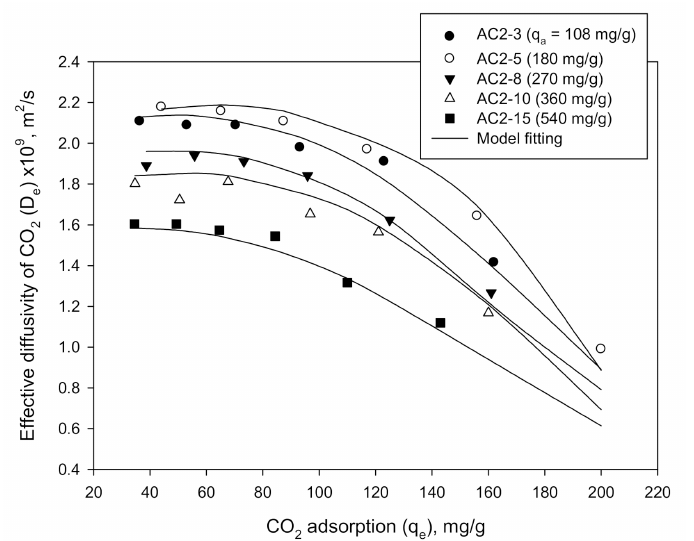
Figure 16. Comparison of experimental and computed effective pore diffusivity (D e ) in Region II and III as a function of CO 2 adsorption capacity for AC2 carbon impregnated with various loadings of